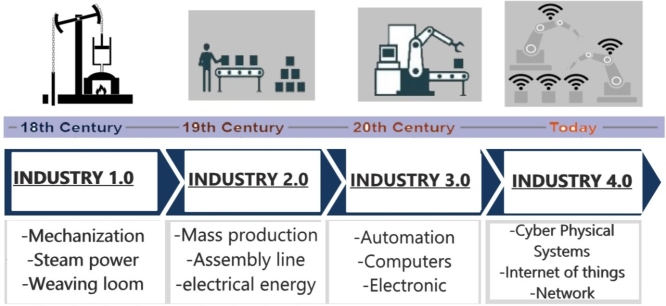
History of Industrial Revolution [42].